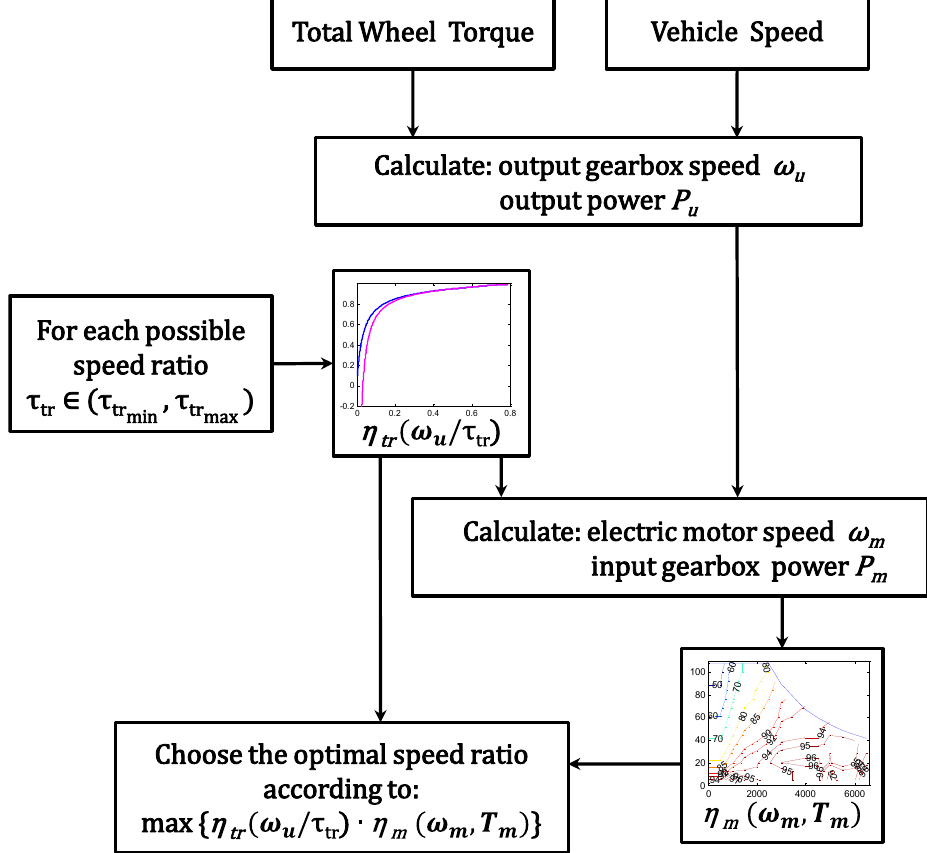
Figure 10. Flow-chart of the optimization algorithm for the IVT